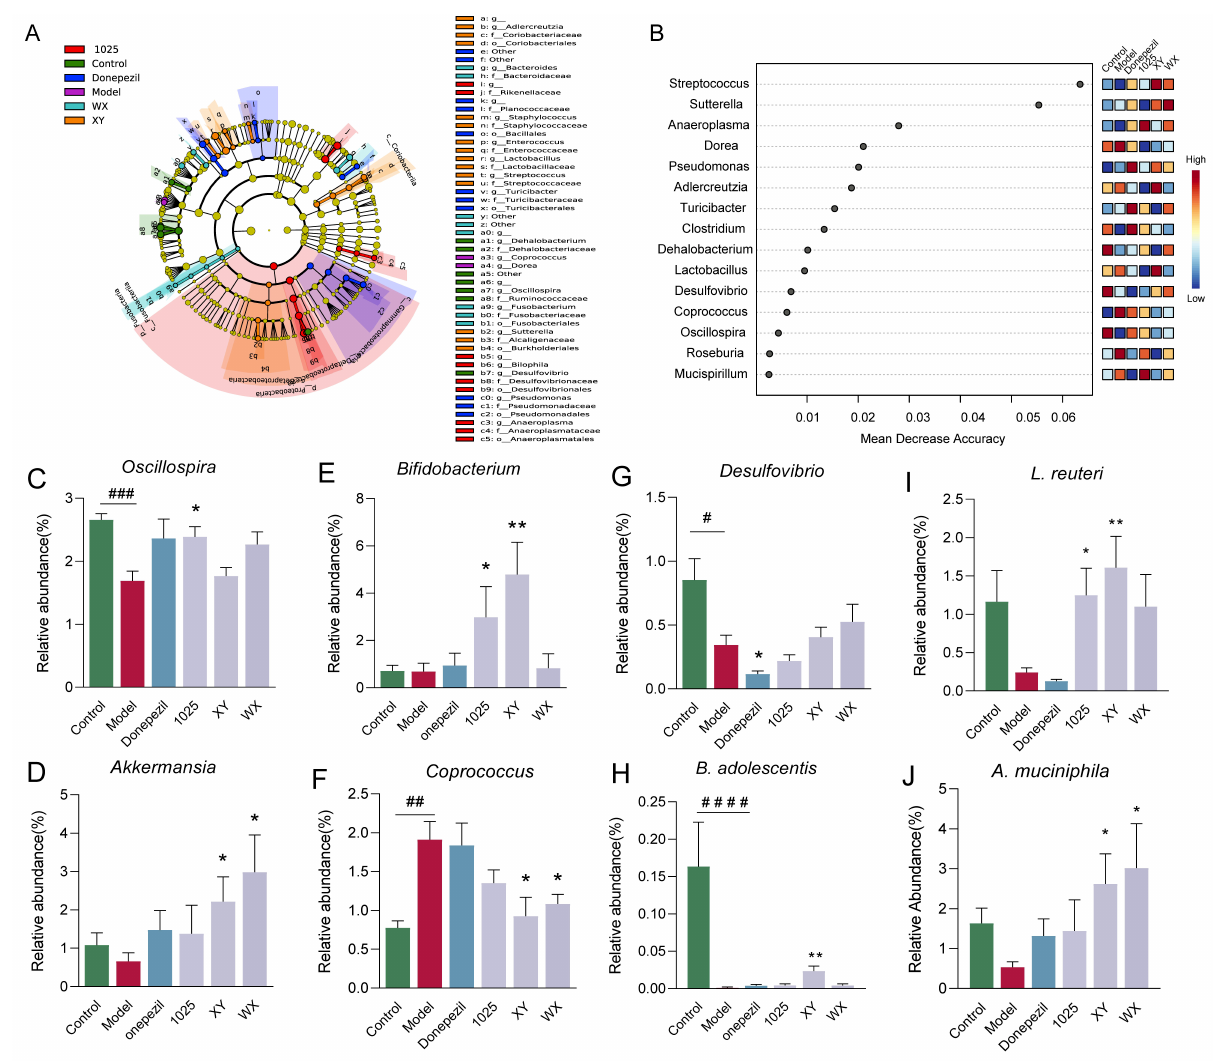
Figure 7. Effect of Bifidobacterium breve supplementation on the composition of the gut microbiota. ( A ) Linear discriminant analysis (LDA) effect size (LEfSe). Differential taxa are labeled with tags and annotated in the right panel. Data were computed with an LDA score above 2.00 and p -value below 0.05 for the factorial Kruskal–Wallis test. ( B ) Significant features were identified by Random Forest. The features are ranked by the mean decrease in classification accuracy when they are permuted. ( C – G ) The relative abundance of selected taxa at the genus level ( n = 6–8). ( H – J ) The relative abundance of selected taxa at the species level ( n = 6–8). Data are presented as mean ± standard error of the mean (mean ± SEM). Control vs. Model: # p < 0.05, ## p < 0.01, ### p < 0.001, #### p < 0.0001 by unpaired student’s t -test; * p < 0.05, ** p < 0.01 by one-way